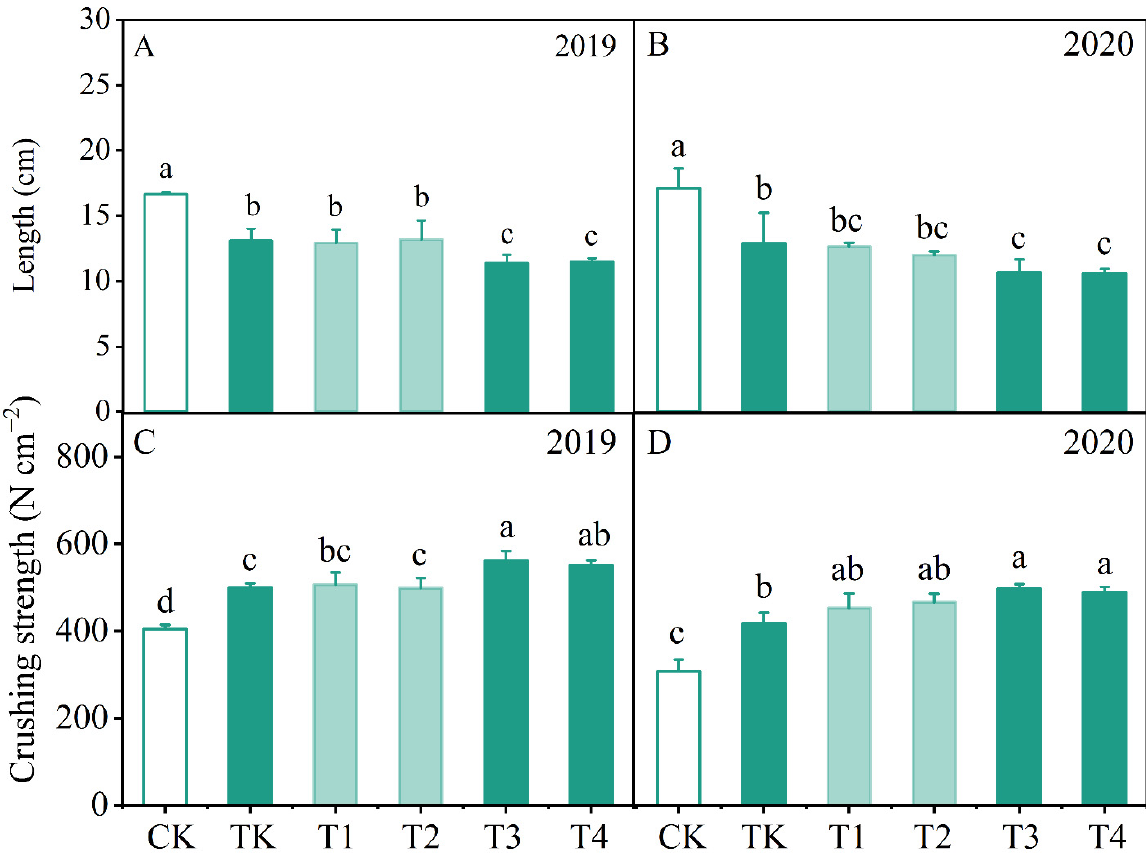
Figure 8. Length and internode crushing strength of the basal internode. The length of the eighth internode in 2019 ( A ) and 2020 ( B ). Internode crushing strength of the basal internode in 2019 ( C ) and 2020 ( D ). The same color in a column represents the equal dosage of EDAH. One-way ANOVA followed by Tukey test was used, and different letters above the bars indicated the significant dif- ferences ( p < 0.05) among treatments. Bars are the standard deviation of three replications.